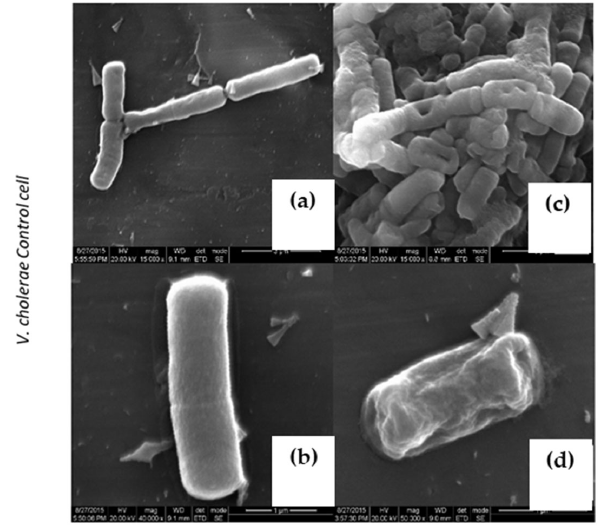
Figure 5. Characteristic morphological changes in V. cholerae . ( a , b ) Untreated cells. ( c ) Treated with LBP at Sub MIC (30 µ g/mL), ( d ) Treated with at Sup MIC (60 µ g/mL).